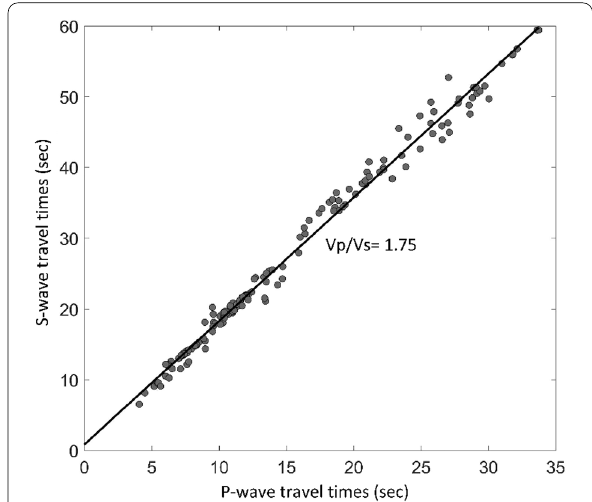
Fig. 5 Wadati diagram for the events used in this study. The estimated Vp/Vs ratio is 1.75